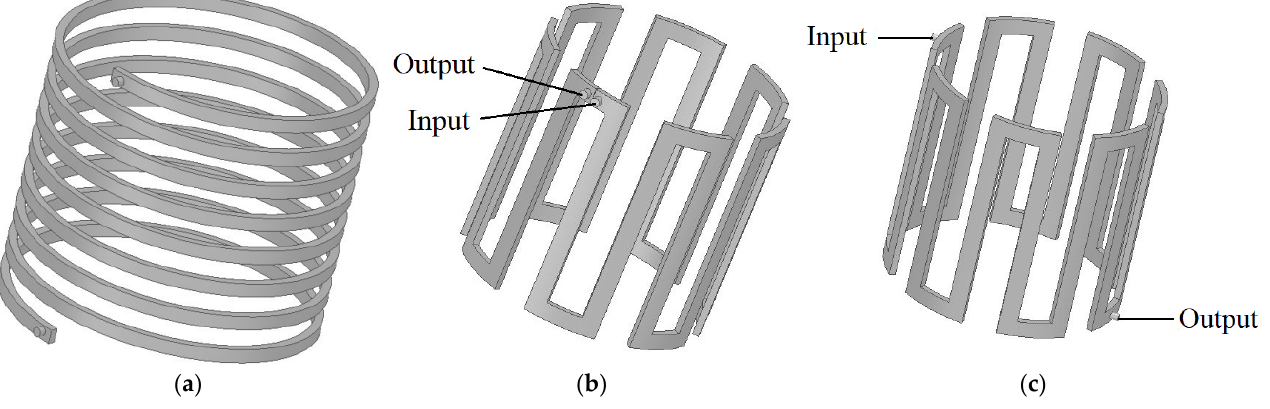
Figure 12. Cooling channel structures. ( a ) Spiral structure; ( b ) axial structure 1; ( c ) axial structure 2.